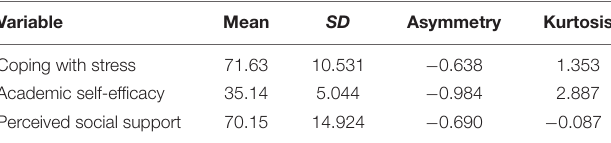
TABLE 1 | Descriptive analysis of coping with stress, academic self-efficacy, and perceived social support. Variable